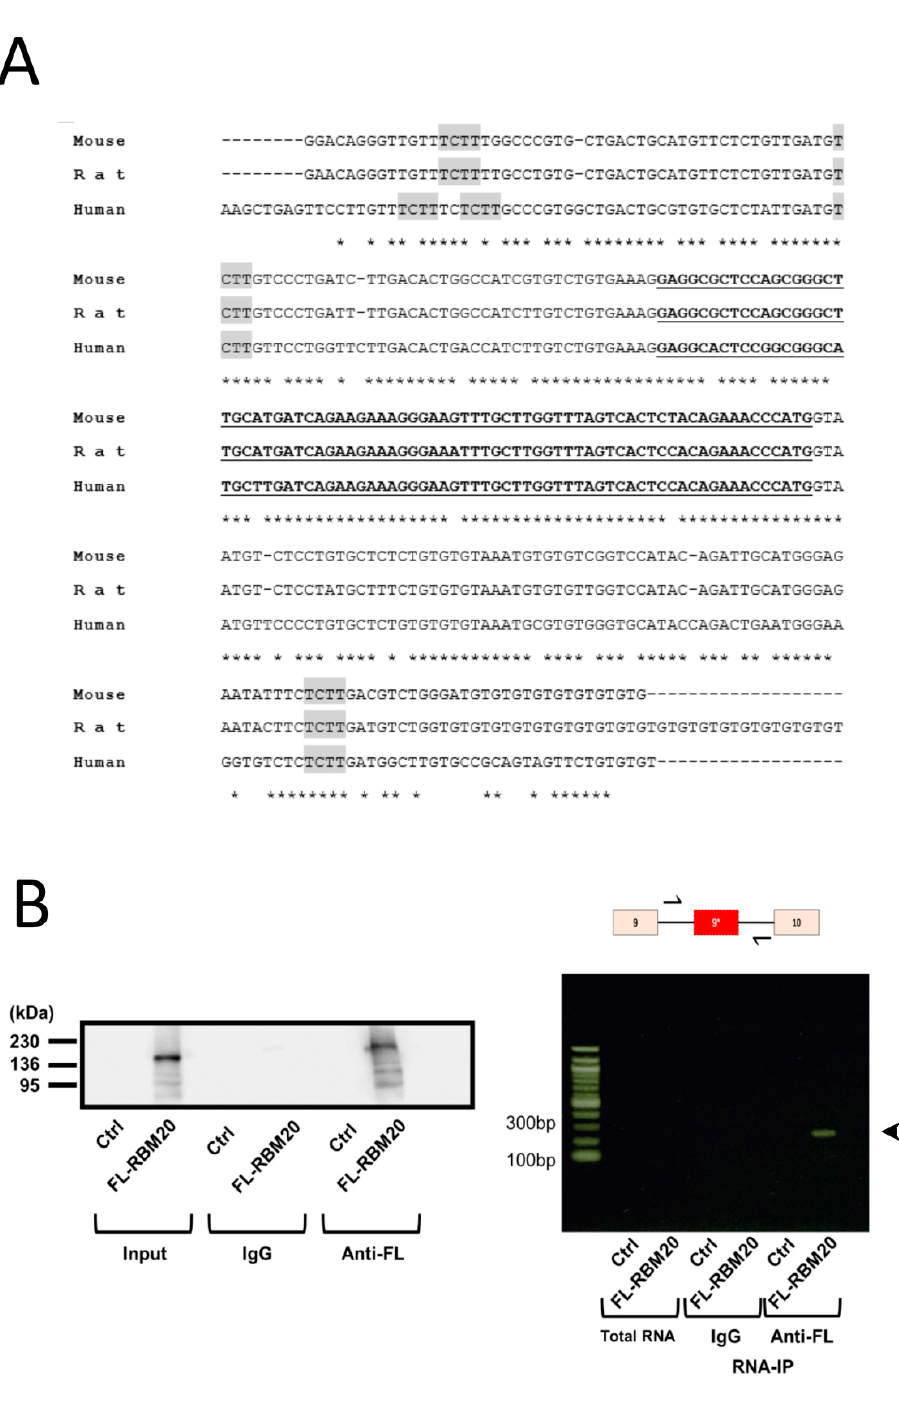
Figure 3. RBM20 bound to introns surrounding exon 9*. ( A ) Sequence allignment of exon 9* (bold and underlined) and partial flanking introns of exon 9* from mice, rats, and humans. Three conserved putative RBM20 binding sites (TCTT) in all three species are highlighted in gray. Stars under the sequences indicate inadequate sequence homology between the tree species. ( B ) RNA IP expression of FLAG-tagged RBM20 overexpressed in neonatal rat cardiomyocytes. Left is a picture of a Western blot showing FLAG-tagged RBM20 expression of immunoprecipitated extracts with IgG or anti-FLAG M2 antibodies. Right is a picture of agarose gel from an RT-PCR amplicon resulting from RNA IP. Upper scheme shows the exon–intron region from exon 9 to 10, with arrows indicating the forward and reverse primers used in this experiment. Pictures are representative of three independent RNA IPs from three di ff erent cardiomyocyte